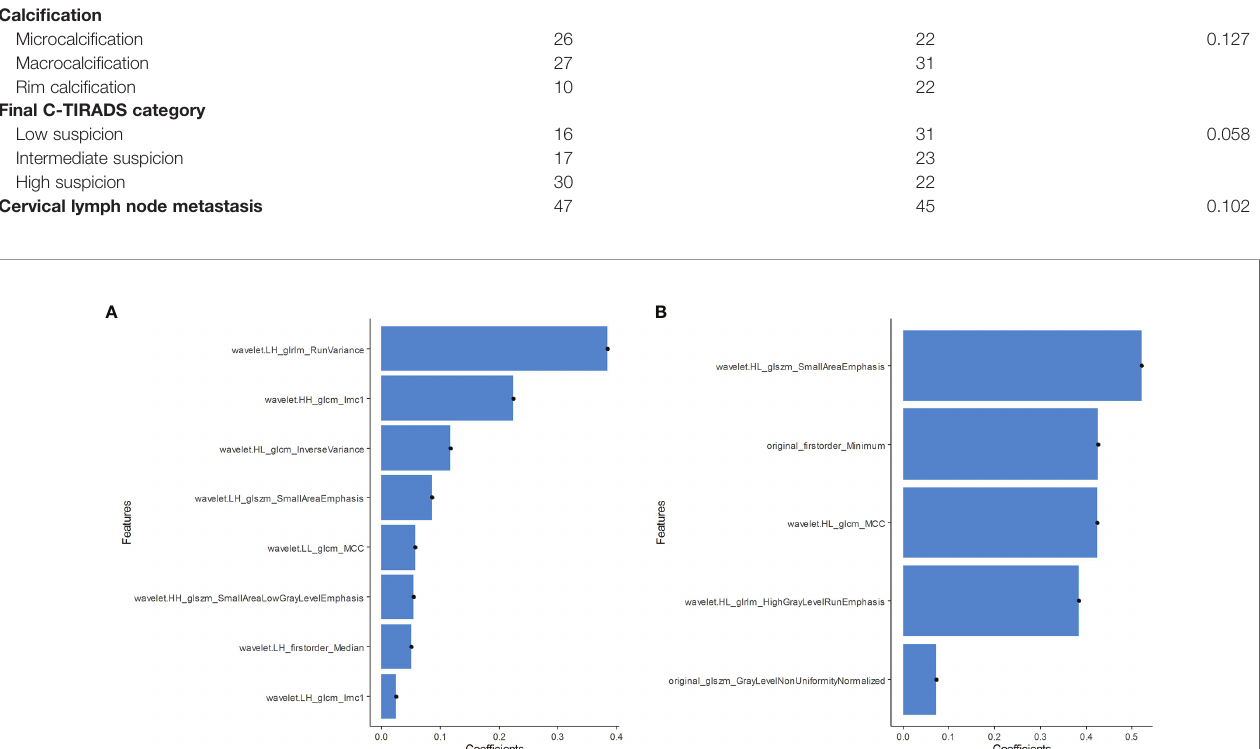
FIGURE 3 | (A) Grayscale features were reduced to eight BRAF V600E mutation-related features in the training cohort. (B) The elasticity features were reduced to fi ve risk predictors in the training